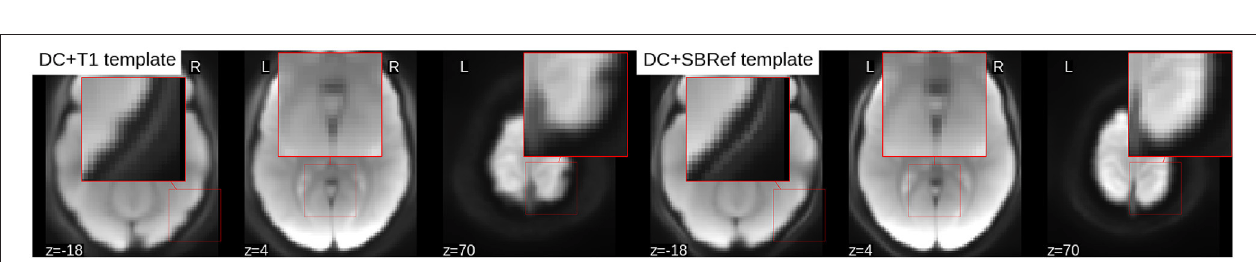
FIGURE 5 | Mean EPI image across all subjects after registration (aka estimated population templates). Patches on the images have been zoomed to highlight details. The mean image from the indirect T1-based pipeline (Left) is more blurry (as seen here in the cerebellum), compared to our direct EPI-based pipeline post-registration across-subject mean image (Right) which is much sharper, indicative of a better inter-subject registration. Also the mean image from the T1-based pipeline has ripples on the cortical surface indicative of residual registration problems, that can be attributed to residual EPI-distortions not captured by coregistration.